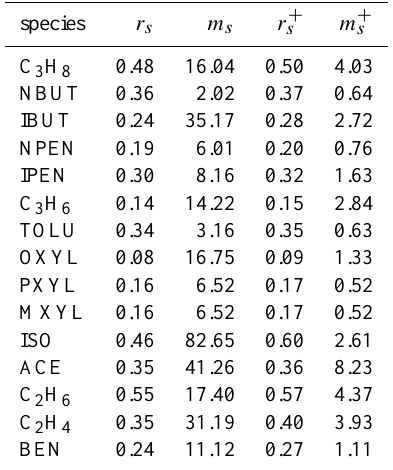
Table 5. Estimated standard deviations of the observation error ( r s and r + s ) and background error ( m s and m + s ), under the Gaussian likelihood and truncated Gaussian likelihood. r s and m s are related to case B1 and case B2, while r + s and m + s are related to case C. The units of r s and r + s are µgm − 3 , while m s and m + s are